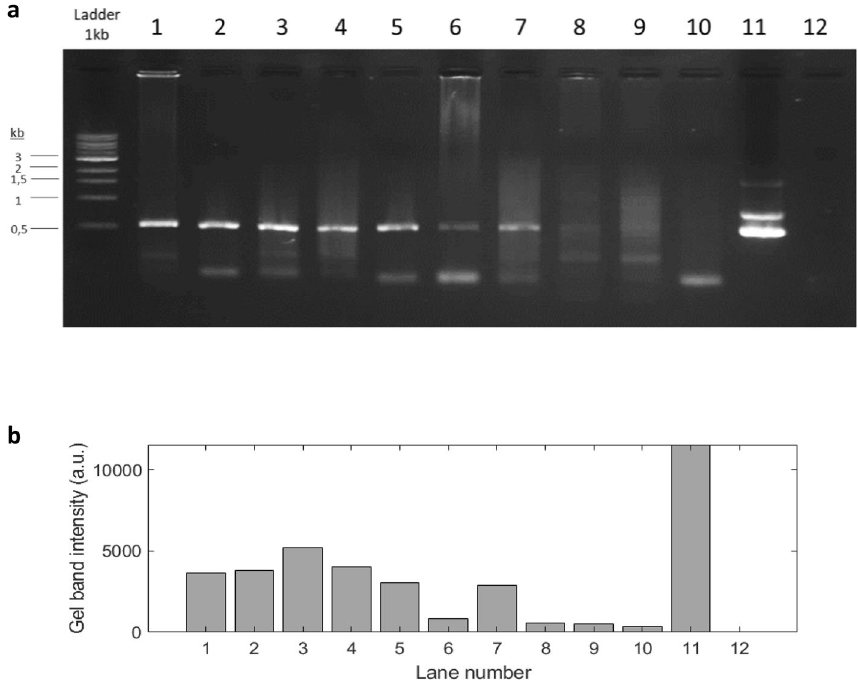
Figure 3. Representative PCR amplification profile for HCV-core region overtime using blood samples of patient PT1 stored in 903 Protein Saver cards at room temperature. ( a ) Agarose gel electrophoresis of the PCR products; ( b ) Histograms represent a single MFI analysis of PCR products over time. Lane 1–10: amplicons obtained at 15, 60, 90, 120, 165, 195, 255, 285, 360, 390 days of analysis, respectively. Lane 11: positive control pUC-JFH1 plasmid. Lane 12: non template control.